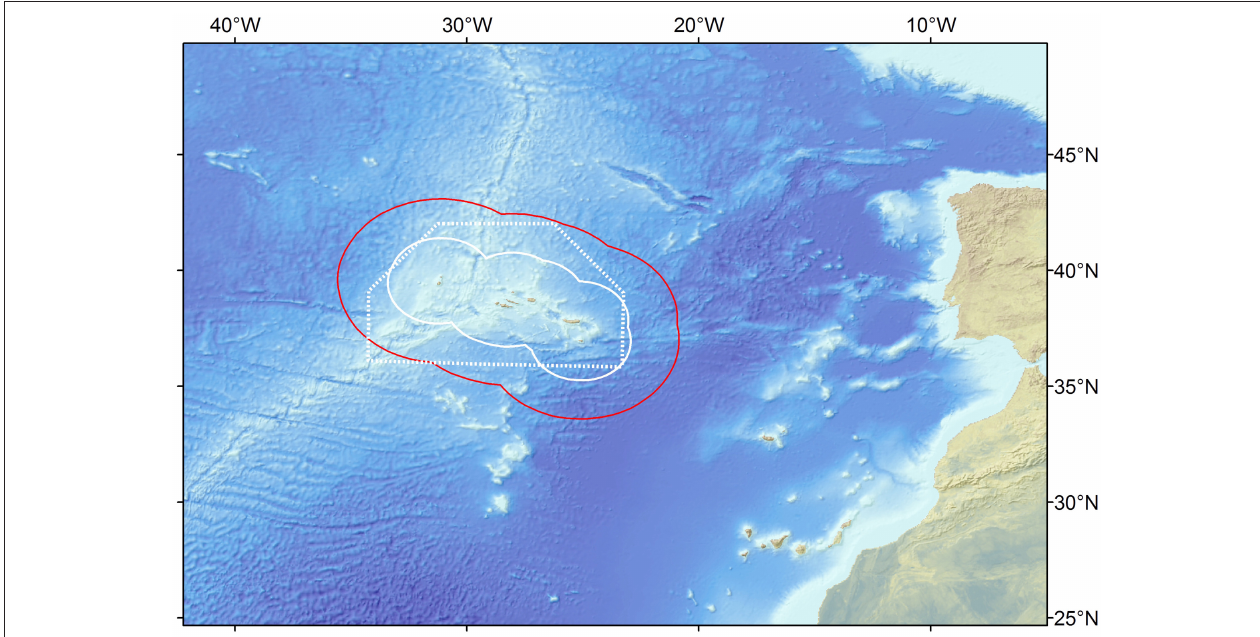
FIGURE 1 | Location of the study area in the Northeast Atlantic showing the Azores archipelago region, its exclusive economic zone (red line), 100nm limit (straight white line) and the trawl ban area (dotted white